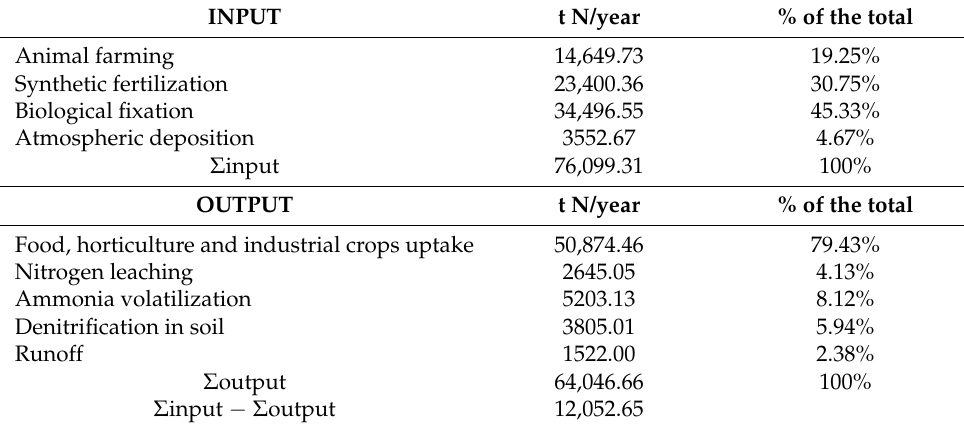
Table 2. The Soil System Budget Model for the Tiber River Catchment (TRC).